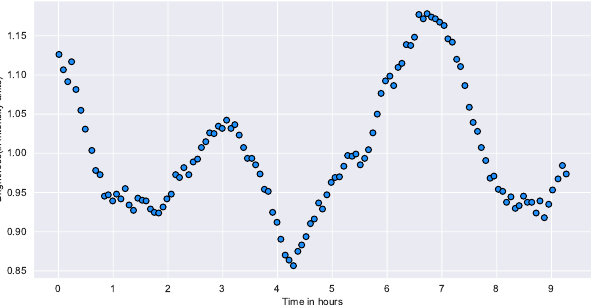
Figure 1. An example of the light curve of No. 13 asteroid (Egeria) in the DAMIT dataset.